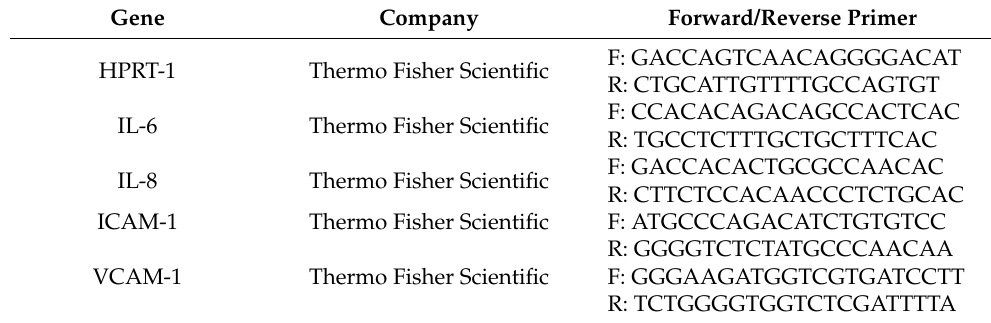
Table 1. Primer sequences used for